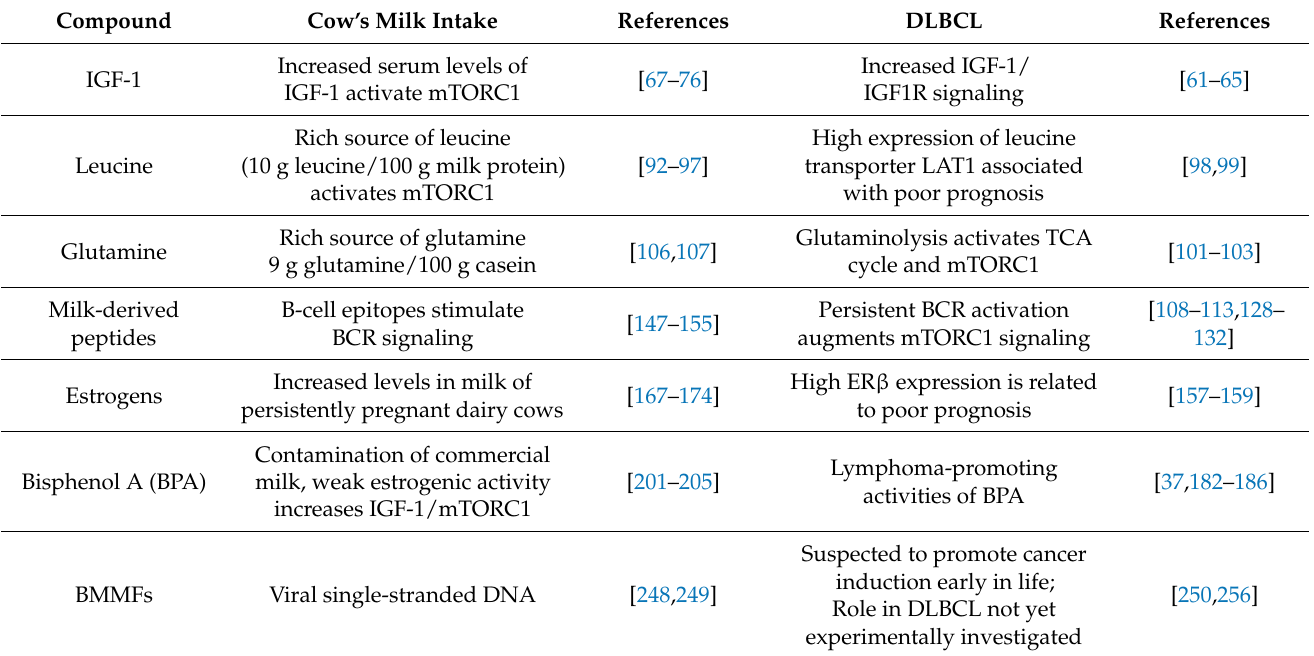
Table 2. Comparison of biologically active compounds related to milk consumption and DLBCL- associated